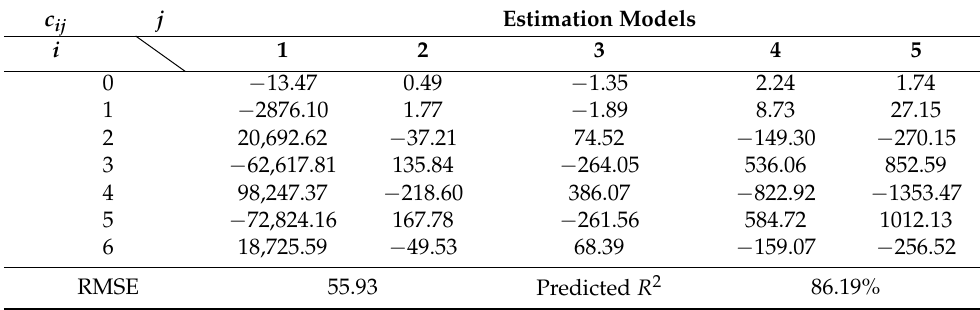
Table 7. Estimated coefficients of the prediction model for σ TR and performance measures (toe). c ij